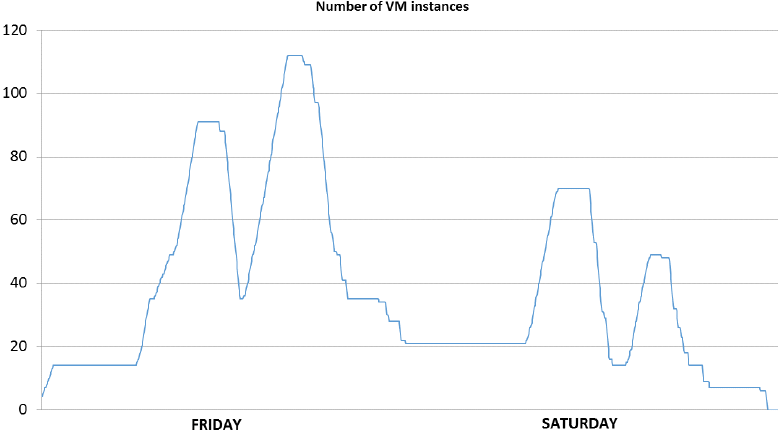
Figure 4. Workload’s shape expressed in terms of virtual machine